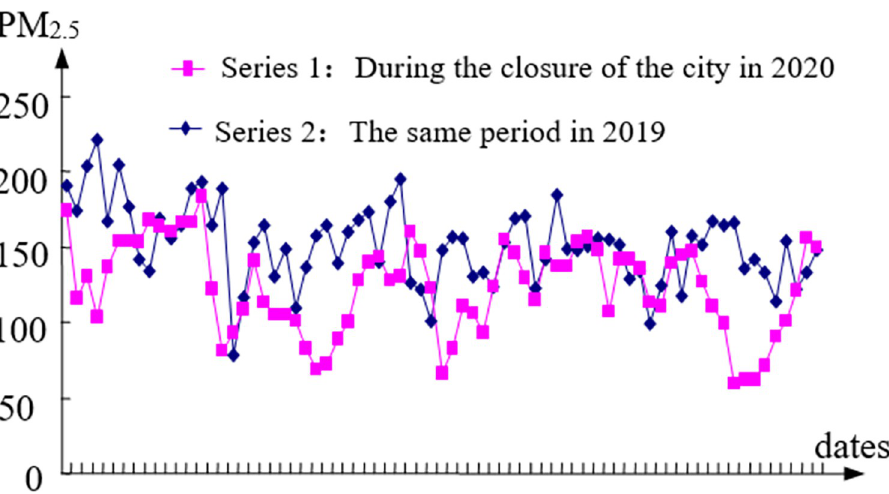
Fig 9. The comparison of PM 2.5